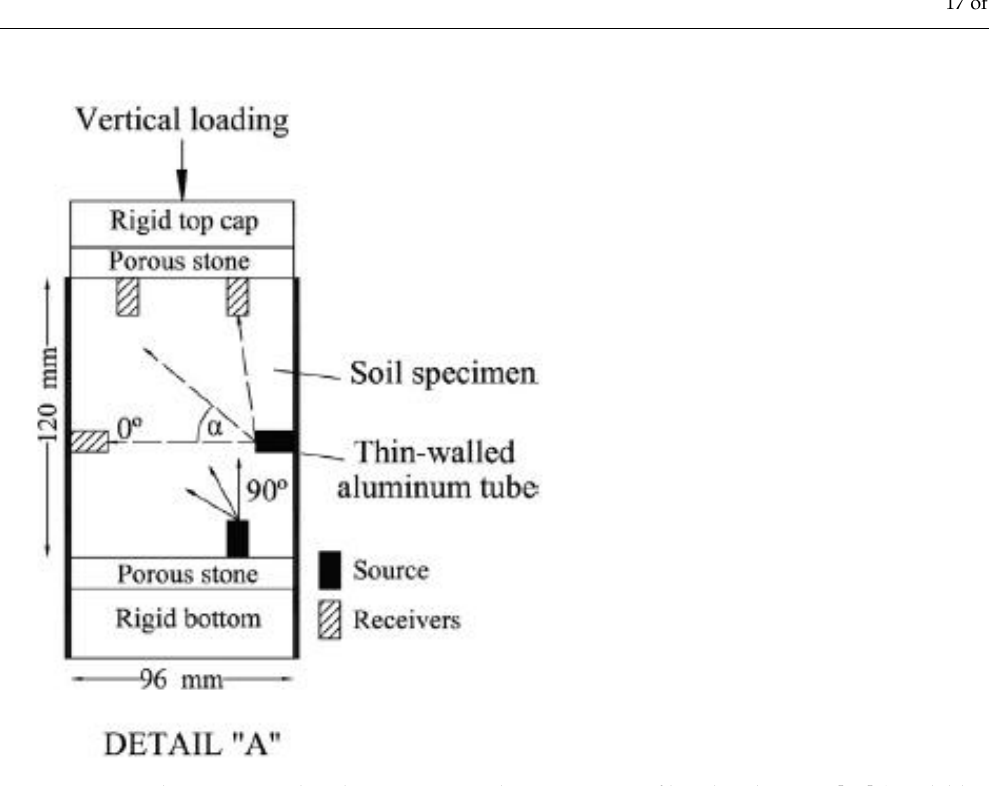
Figure 18. Schematic peripheral equipment and arrangement of bender elements [72] (available via 2020 license CC BY-NC-ND 4.0).